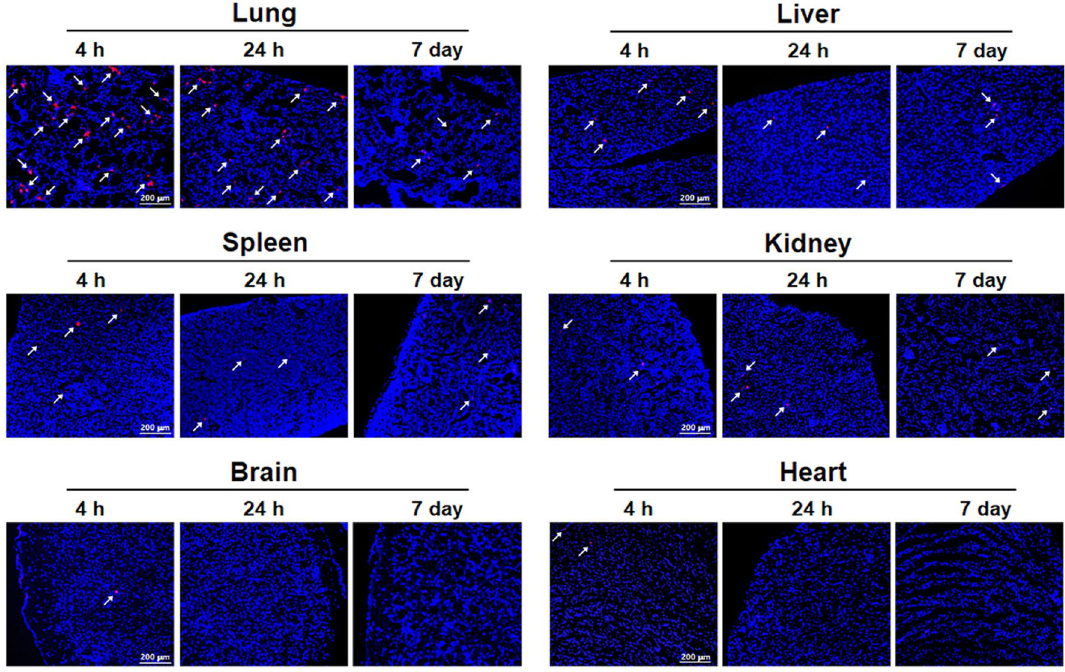
Figure 5. Image of infused AD-MSCs with DiI staining. Distribution of DiI-labeled AD-MSCs were analyzed in lung, liver, spleen, kidney, brain, and heart at 4 h, 24 h, and 7 day after AD-MSCs infused. Scale bar = 200